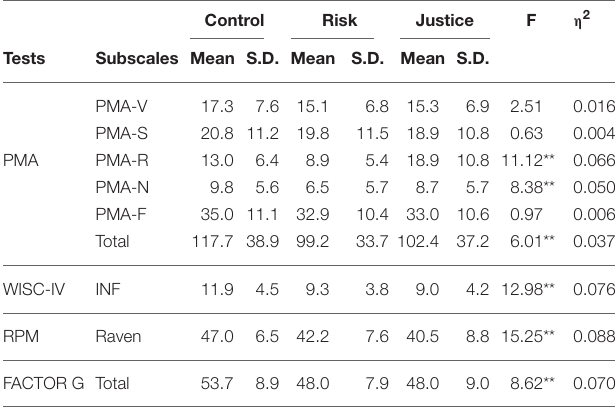
TABLE 4 | Descriptive statistics for the intelligence measures in the three samples and ANCOVA